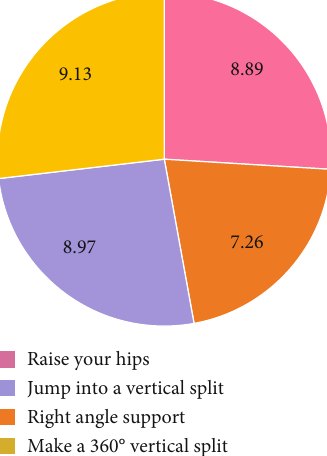
Figure 3: Statistics of di ffi culty movement test results of experimental group after experiment.